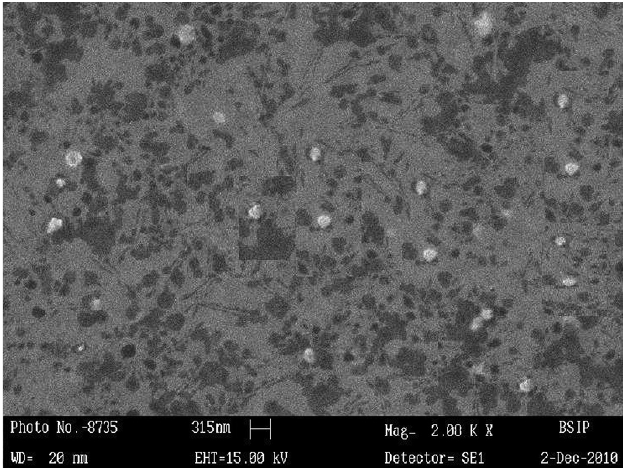
FIGURE 2 - SEM Photomicrograph of selegiline hydrochloride loaded Chitosan